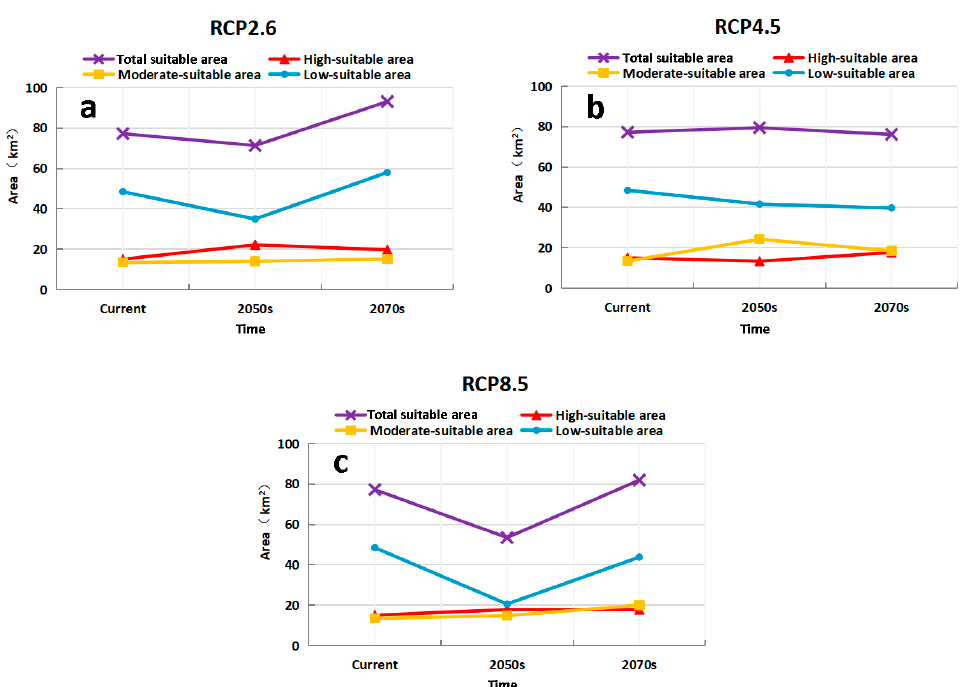
Figure 11. Variation trend of the grades of habitat suitability for M. destructor in Xinjiang under three climatic scenarios.( a ) area in different periods under RCP2.6 (the minimum gas emission scenarios), ( b ) area in different periods under RCP4.5 (the medium gas emission scenarios), ( c ) area in different periods under RCP8.5 (the maximum gas emission scenarios).